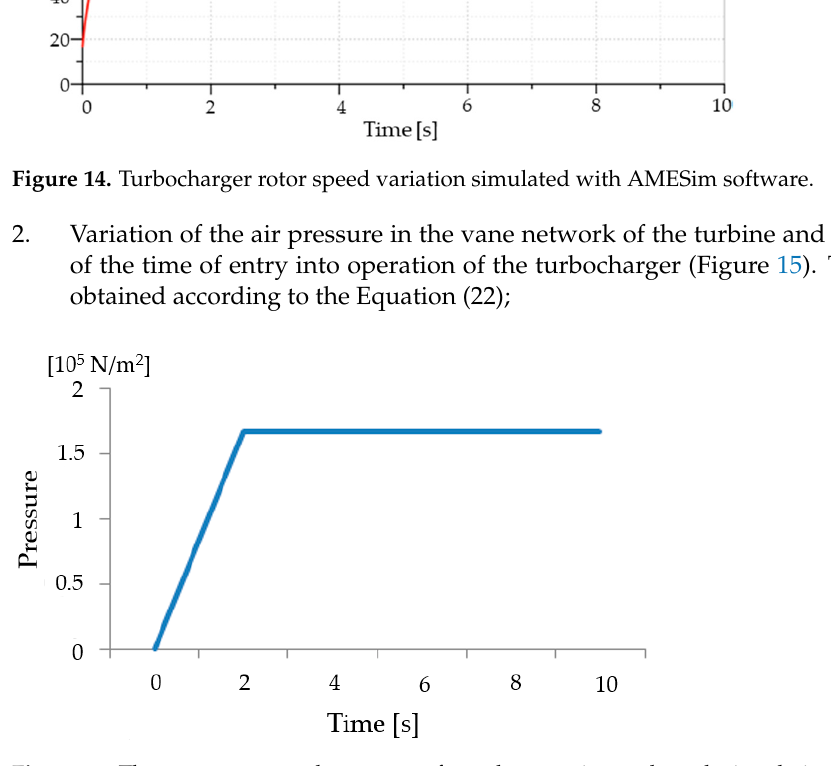
Figure 14. Turbocharger rotor speed variation simulated with AMESim software.